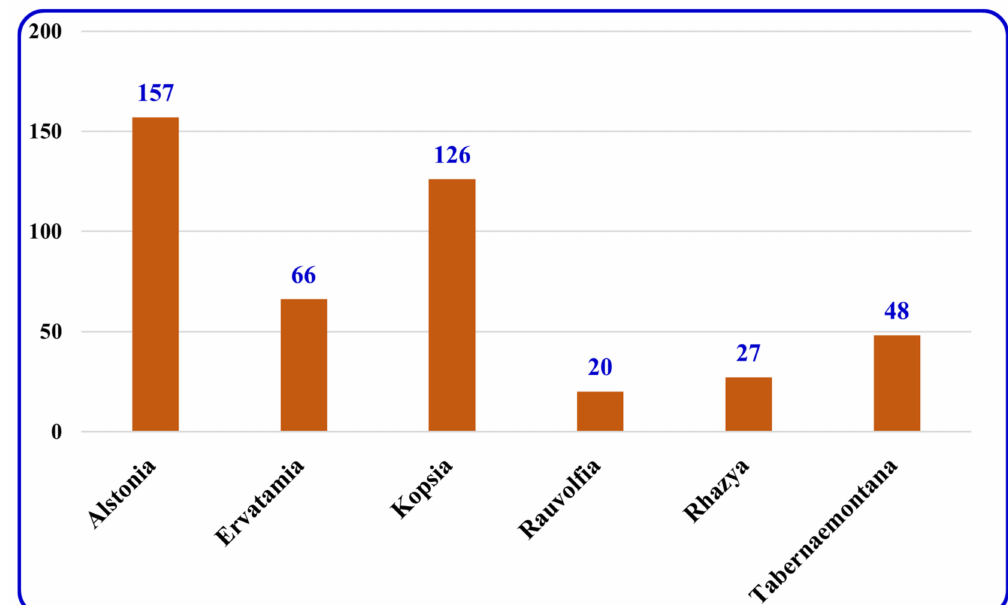
Figure 34. Number of compounds isolated from the six genera.